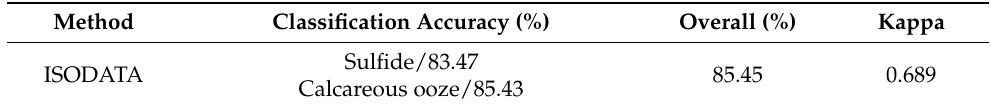
Table 2. Classification accuracy of fuzzy ISODATA unsupervised sediment.